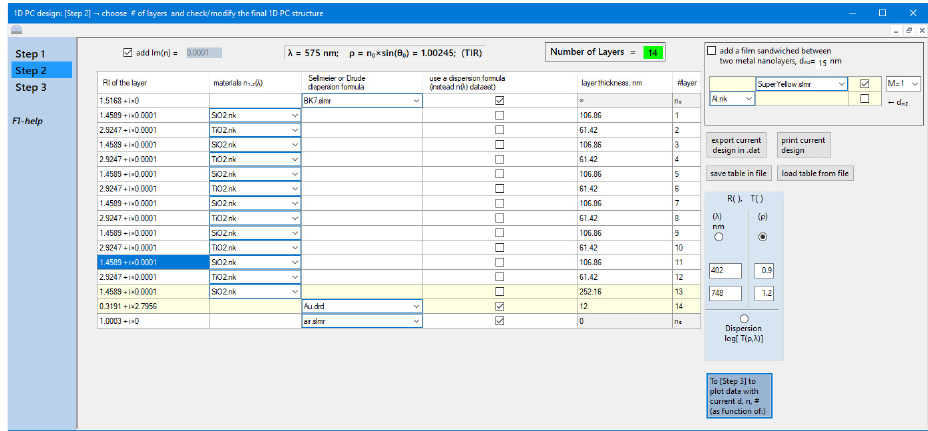
Figure 4. Step 2 program’s window for choosing the number of layers and final adjustment of the